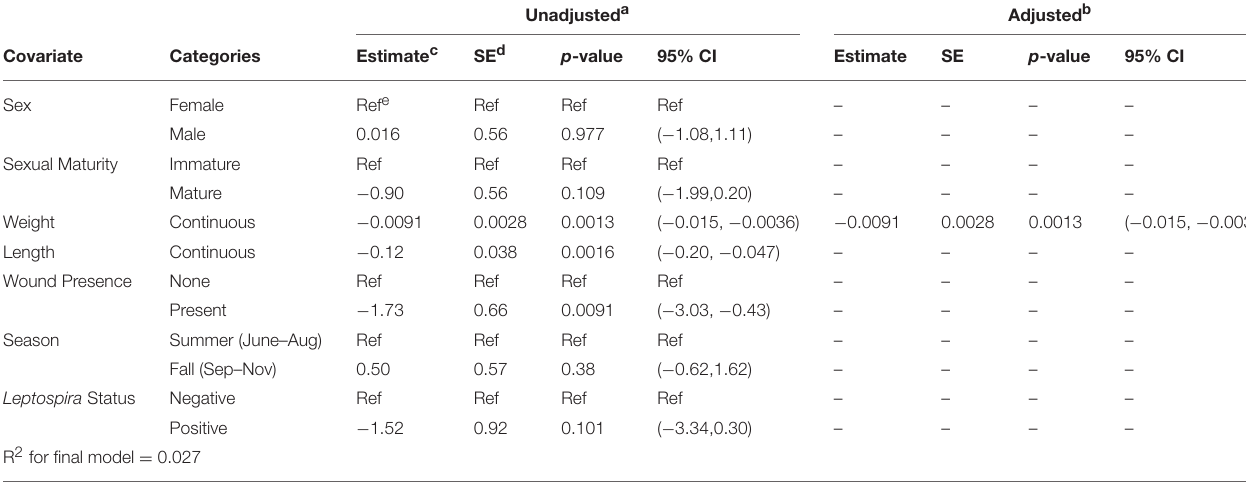
TABLE 2 | Unadjusted (bivariable) and adjusted (multivariable) linear regression of each rat characteristic against the outcome of trap day; N = 379. Unadjusted a Adjusted